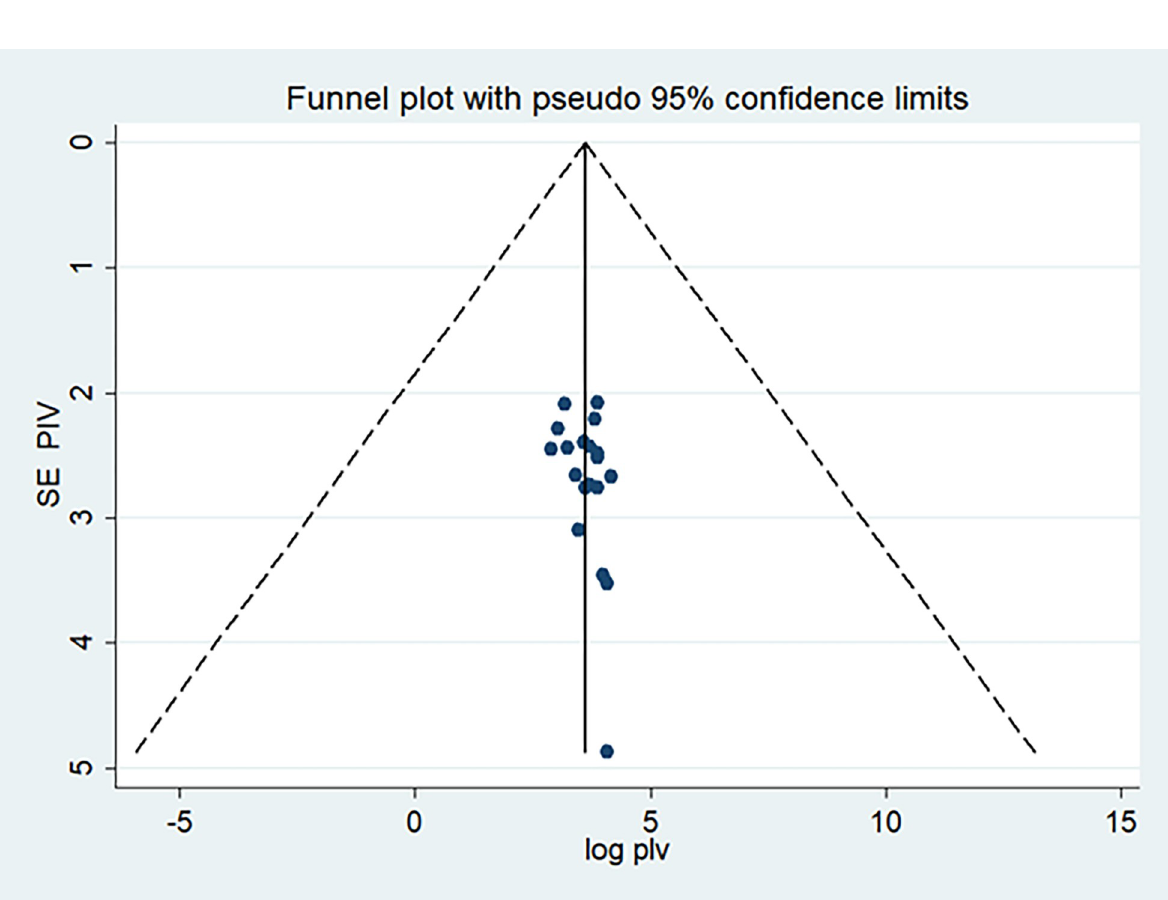
Fig 3. Meta funnels presentations of the proportion of dietary adherence among type 2 DM in Ethiopia, 2012–2020, whereby SE PIV (standard error of proportion) plotted on the Y-axis and log PIV (logarithm of proportion) on the